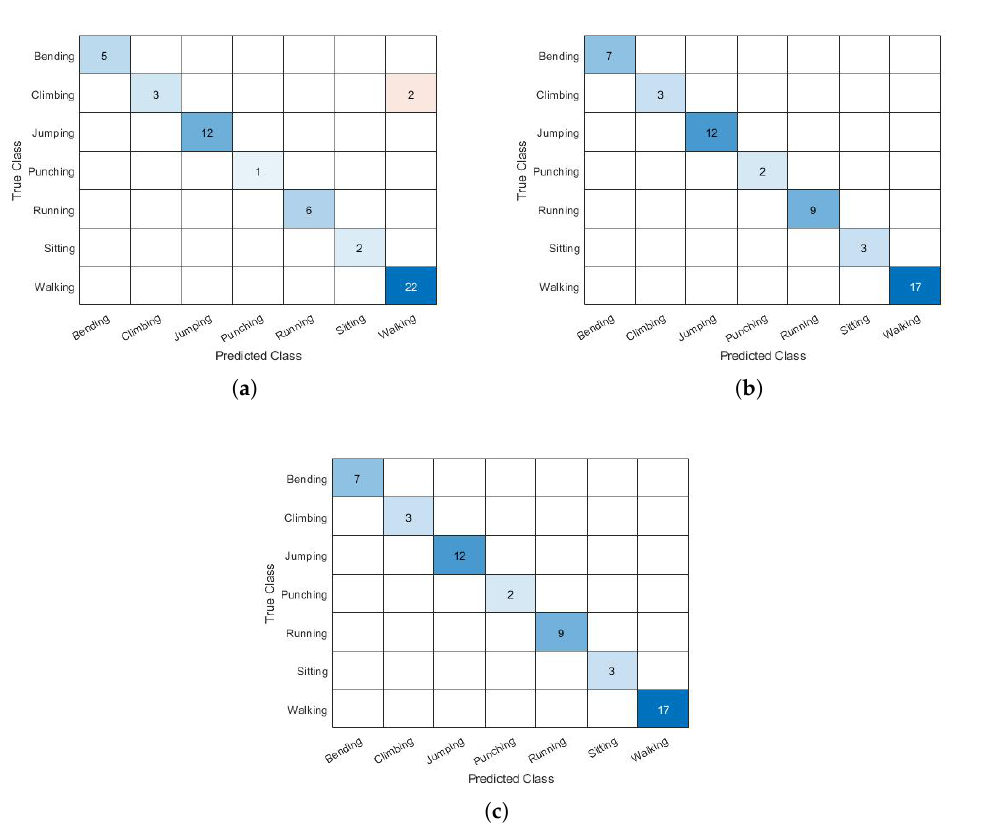
Figure 10. Confusion matrix for seven different human activities. ( a ) Confusion matrix for micro- Doppler signatures; ( b ) confusion matrix for interferometric signatures; ( c ) confusion matrix for dual micro-motion signatures.